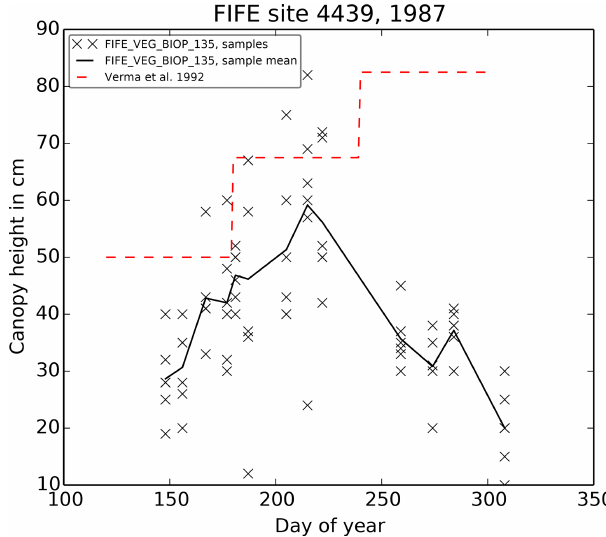
Figure A7. Canopy height in cm for site 4439 for 1987 from